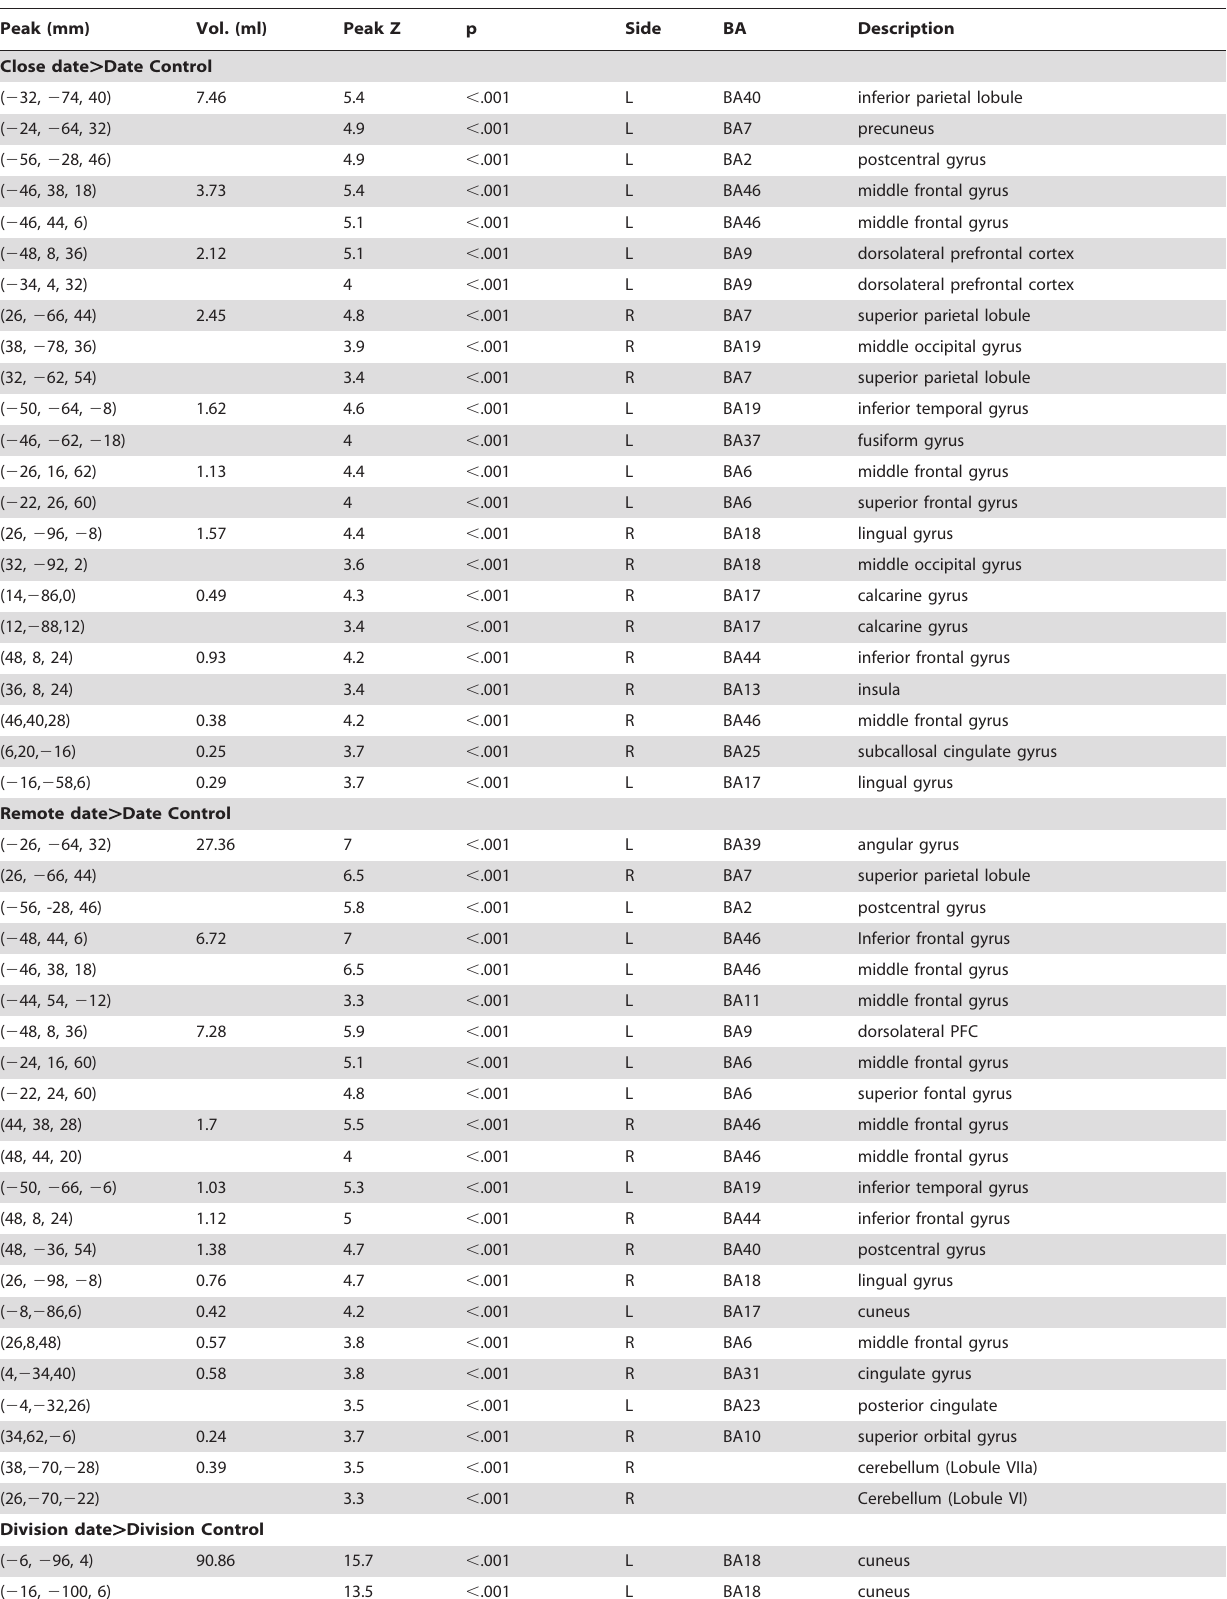
Table 2. Comparison of activity for calendrical tasks and division with their respective control tasks.